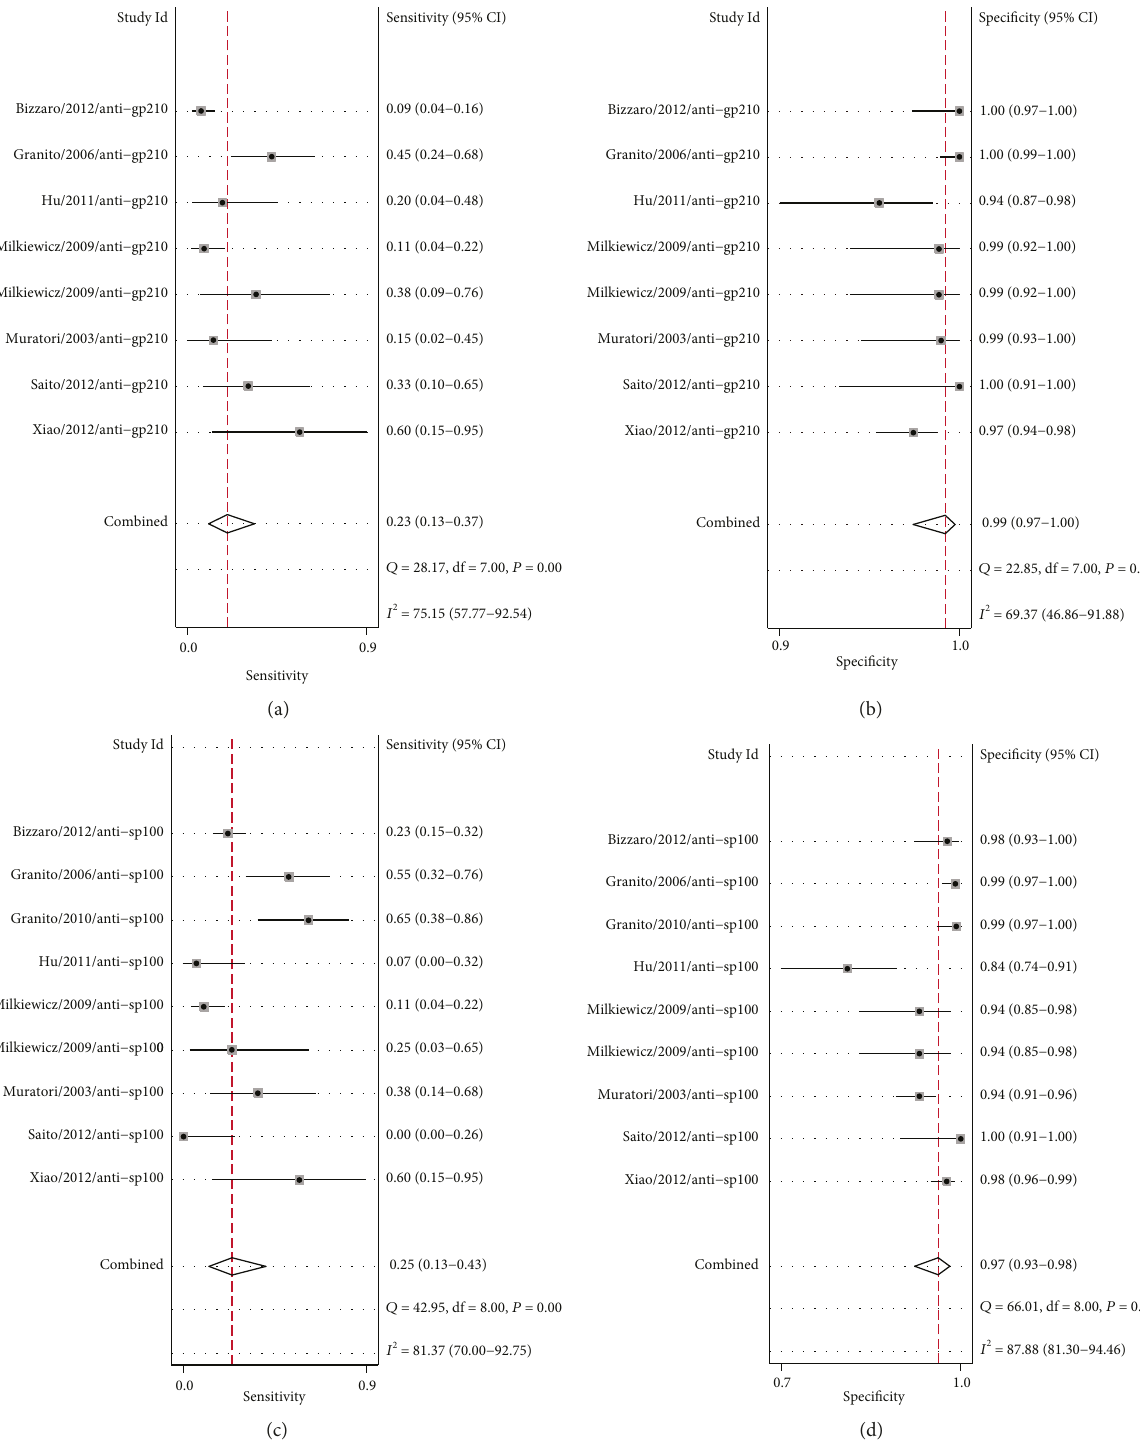
Figure 4: Forest plots of the sensitivity and speci fi city of anti-gp210 (a, b) and anti-sp100 (c, d) in the diagnosis of AMA-negative PBC. In order to distinguish di ff erent ANAs, we listed both the author name with publication years and the di ff erent categories of ANAs. That will lead to one study with more than one forest plot in the fi gure. The fi rst authors and published years are shown together with sensitivities, speci fi cities, and 95% con fi dence interval. Combined sensitivities and speci fi cities are also shown with the results of the Q test and the I 2 test. Abbreviations: AMA: antimitochondrial antibody; PBC: primary biliary